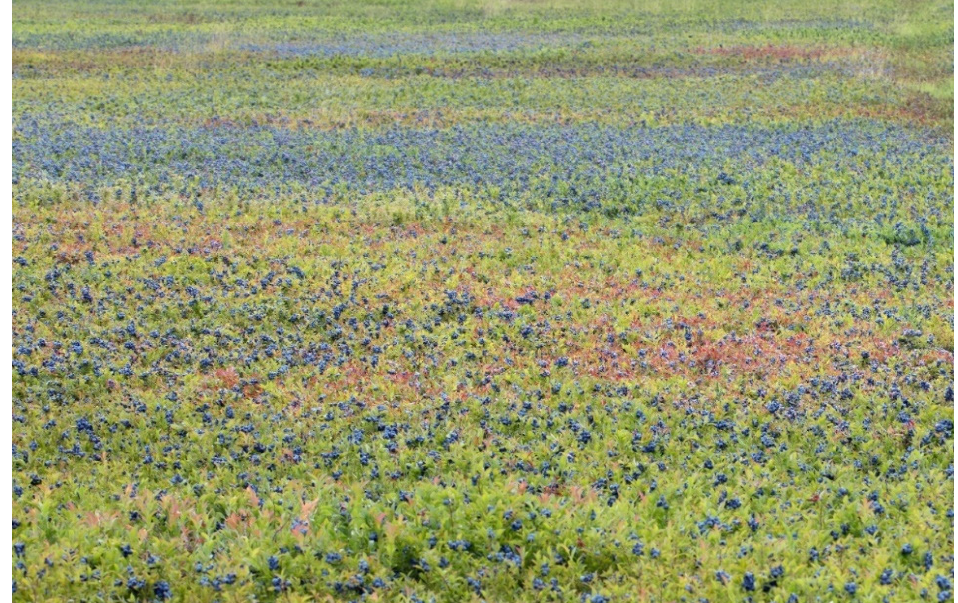
Figure 1. High variations in leaf color, stem height, berry density, and berry color among genotypes in a wild blueberry field at the Wyman’s Farm, Deblois, ME, USA. Different genotypes form patches connecting each other in the field. The photo was taken during the fruit production stage by Dr. Xiaoxue Mo.